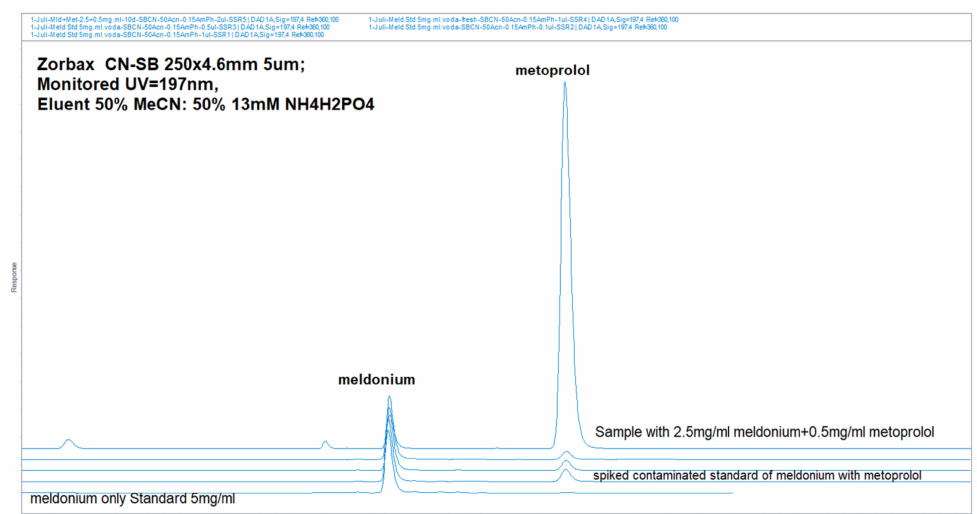
Figure 34. Overlaid chromatograms of meldonium standard pure, standard meldonium contaminated with trace of metoprolol and sample with 2.5 mg/mL meldonium and 0.5 mg/mL metoprolol with